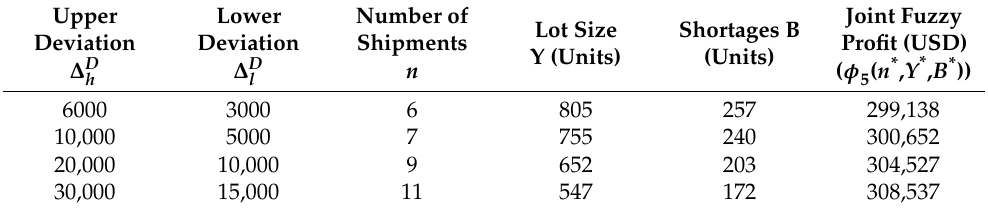
Table 5. Impacts of upper and lower fuzzy deviations on the decision variables and joint fuzzy profit.